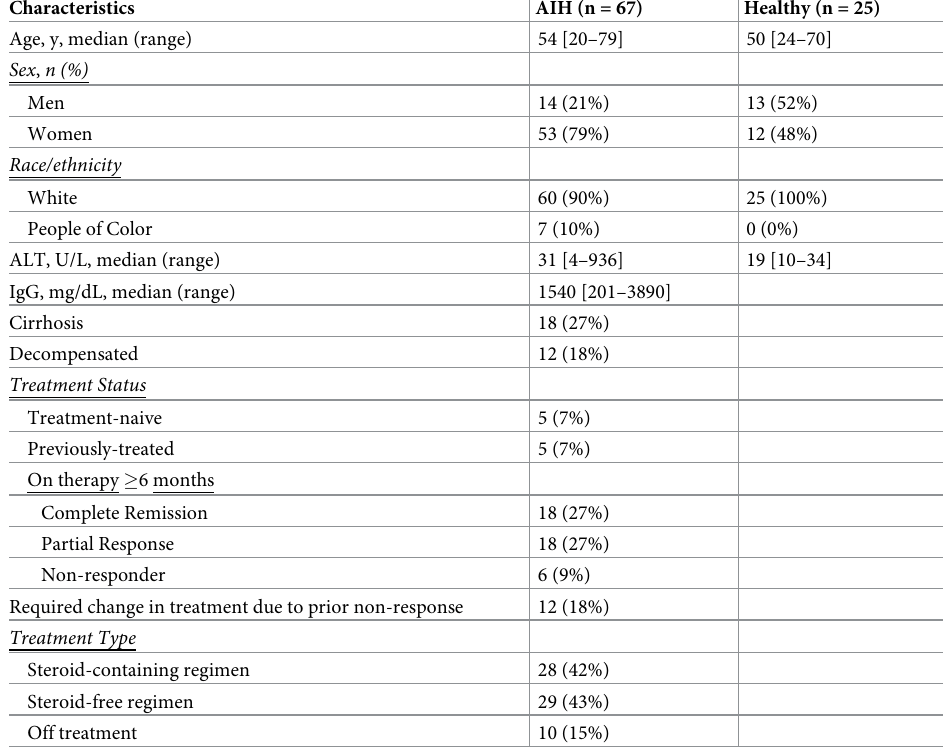
Table 1. Clinical cohort of AIH patients and healthy